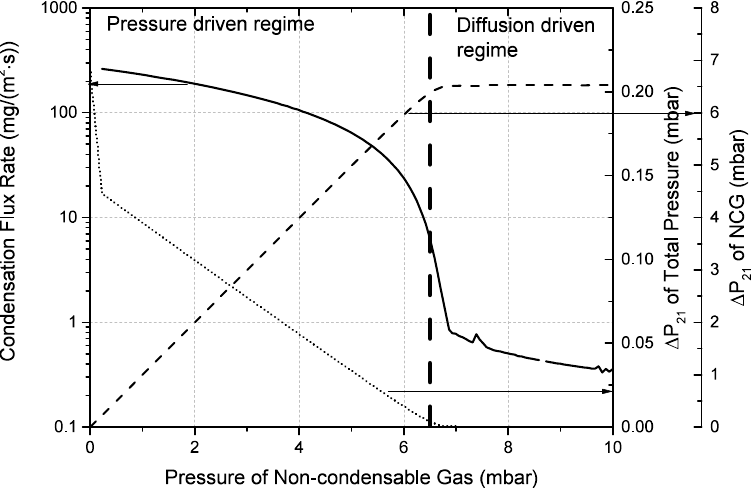
Figure 16. Relation of condensation flux rate (mg/ ( m 2 · s ) ) and the pressure of the NCG at the bottom of vessel 2. In this experiment: evaporation in vessel 1 and condensation in vessel 2, with temperatures respectively 35 and 37 ◦ C. At 6.5 mbar a transition is observed between a pressure and diffusion driven mass transport process. On the right axis the pressure difference (Total and NCG) between two vessels during the simulation of a high leakage rate, both at the bottom of the